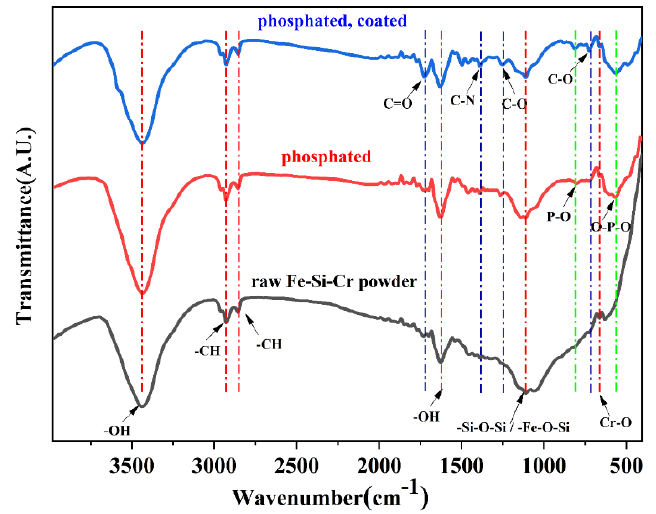
Figure 7. FTIR spectrum of uncoated and coated Fe-Si-Cr powder (from bottom to top is the raw powder, phosphated powder, and phosphate-coated powder.